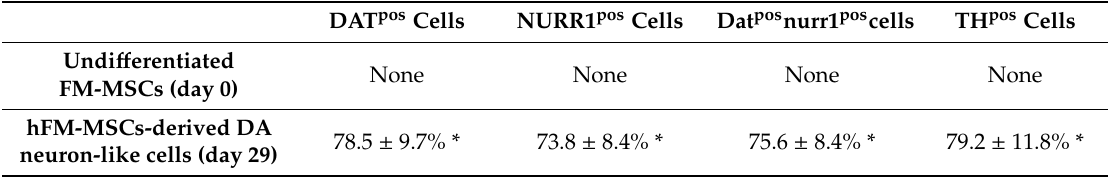
Figure 5. Immunofluorescent analysis of NURR1 and DAT in hFM-MSCs-derived DA neuron-like cells. Immunostaining for DAT (green) and NURR1 (red) in undifferentiated cells (day 0) and in DA neurons (day 29). The nuclei were counterstained with DAPI. Original magnification: 40×, scale bar 20 μ m. Immunofluorescence images are representative of three independent experiments. Table 1. Percentage of cells positive for DAT, NURR1, and TH.